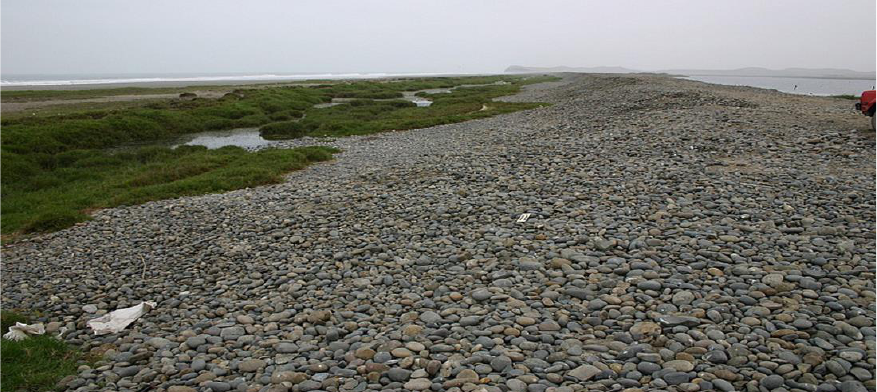
Figure 27. Coastal beach ridge formation on north coast of Peru formed from a major El Niño flood event. Photo by author at Supe Valley coast in Peru.